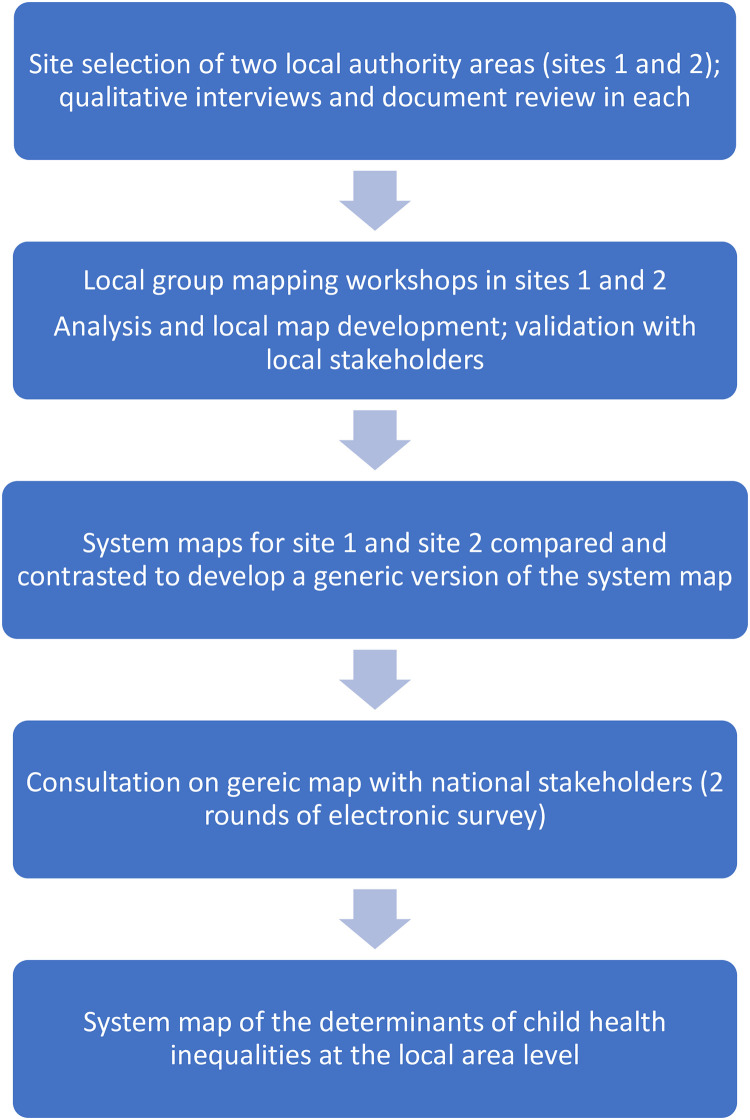
Overview of methods.